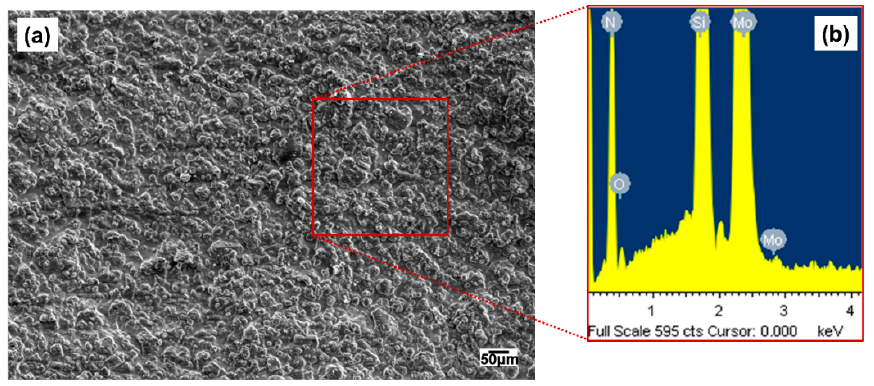
Figure 3. Surface of the as-coated MoSi 2 -Si 3 N 4 outer layer: ( a ) SEM image; ( b ) EDS pattern corresponding to the marked red square in Figure 3a.